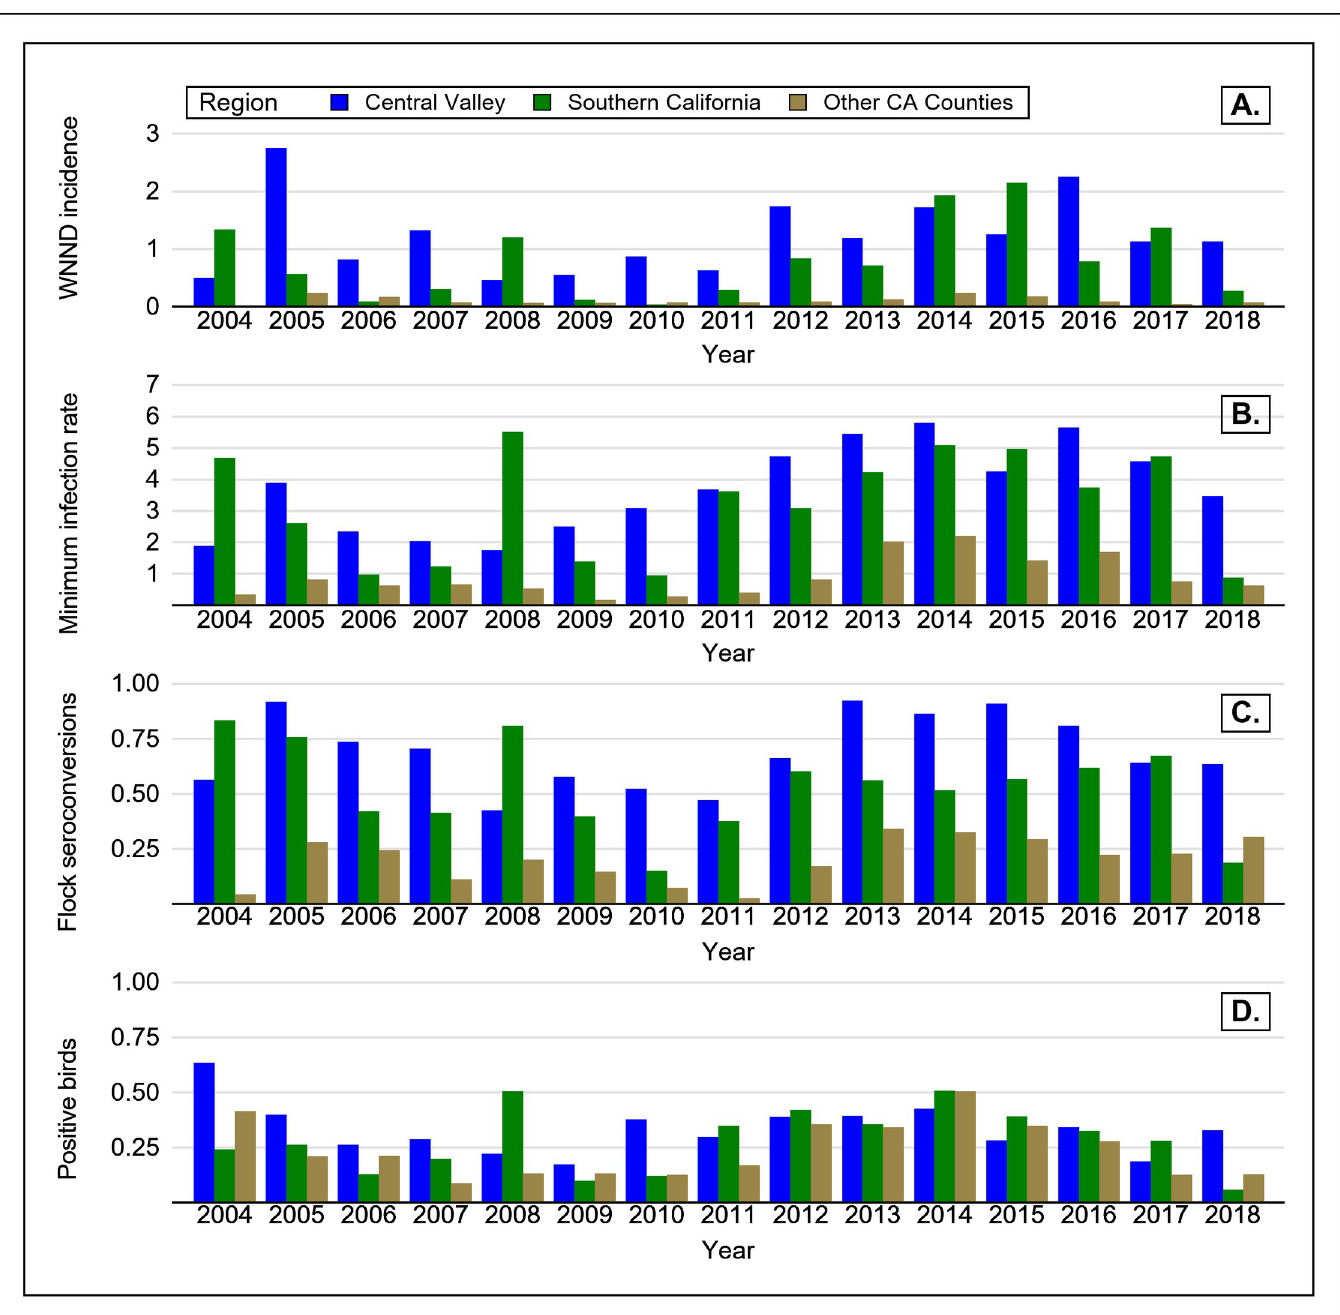
Fig 5. West Nile virus activity by year and region in California, 2004–2018, A) West Nile neuroinvasive disease incidence per 100,000 persons (annual), B) mosquito minimum infection rate per 1,000 mosquitoes tested (July-October), C) proportion of sentinel chicken flocks that seroconverted (July-October) and D) proportion of tested dead wild birds positive for WNV